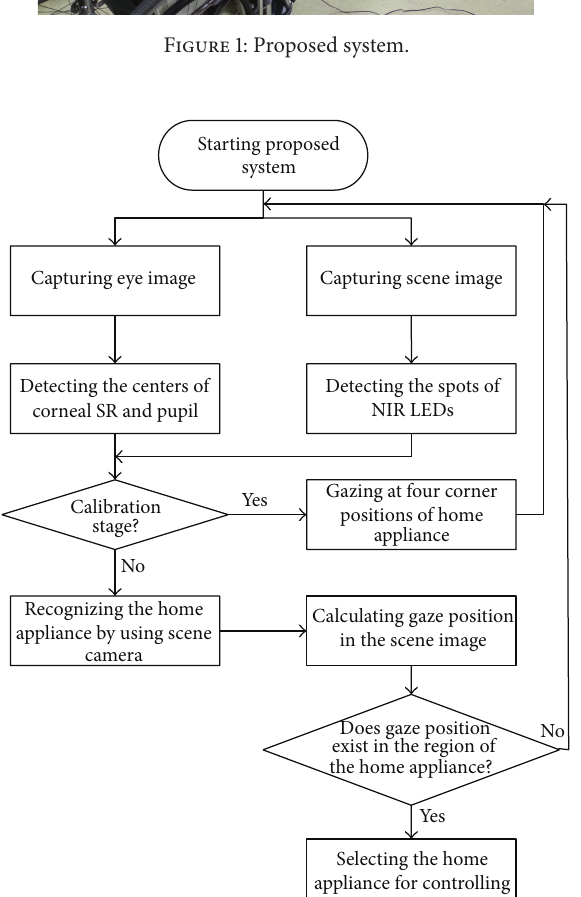
Figure 2: Flowchart of the proposed